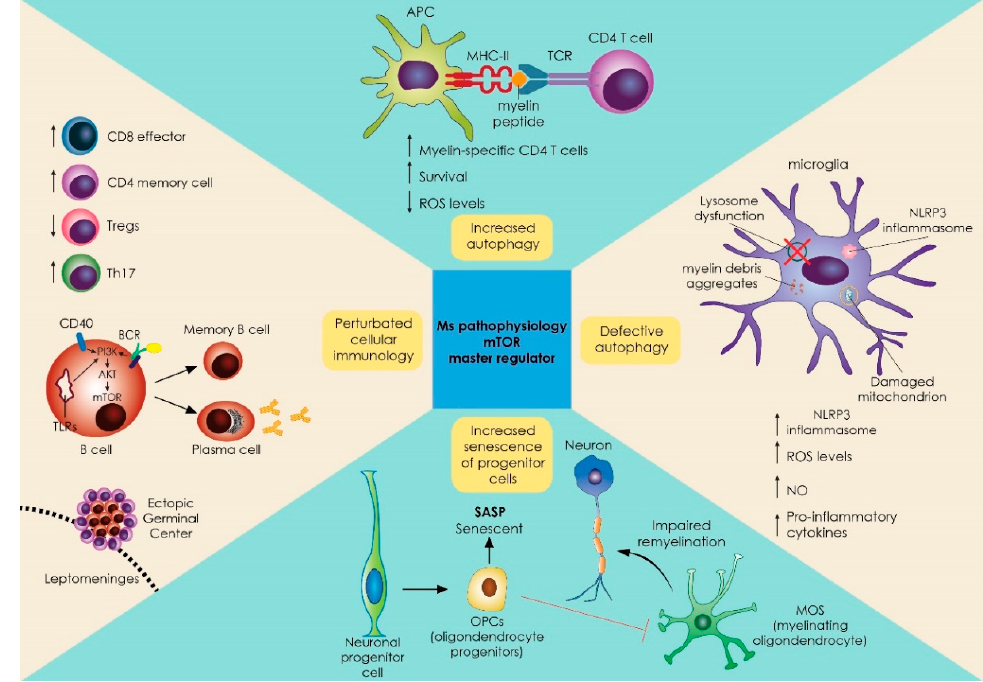
Figure 2. mTOR signaling pathway as a master regulator of many aberrant immune responses and biological processes implicated in MS pathogenesis. mTOR is critical in the development and function of various immune cells that play an important role in MS pathology. The picture shows the effects of mTOR inhibition in T cells, B cells, oligodendrocyte progenitor cells, macrophages, and microglial cells, as well as the effects of mTOR on the autophagy process that regulates the inflammatory phenotype of various cells such as neurons, microglia, and other glial cells. In the top part, increased levels of autophagy could lead to enhanced myelin processing, and antigen presentation to CD4 autoreactive T-cells in antigen presenting cells. Increased autophagy also prolongs survival of activated CD4 and CD8 T-cells. On the right, defective autophagy leads to aberrant clearance of damaged mitochondria, inflammasomes, and myelin debris in microglia, and fuels a pro-inflammatory phenotype. At the bottom of the figure, neural progenitors are affected by the presence of SASP, affecting the differentiation of OPCs and reducing remyelination of neurons. On the left, upstream regulation of BCR, CD40, and TLR signaling leads to a downstream PI3K/AKT/mTOR pathway and differentiation of B cells by T cell help, promoting the anabolic process of dark zone centroblast proliferation. AKT: protein kinase B; APC: antigen-presenting cell; BCR: B cell receptor; Th: T helper cell; PI3K: phosphoinositide 3-kinase; MHC: major histocompatibility complex; mTOR: mammalian target of rapamycin; NLRP3: nucleotide-binding oligomerization domain (NOD)-like receptor protein 3; NO: nitric oxide; ROS: reactive oxygen species; SASP: senescence-associated secretory phenotype; T reg: T-regulatory